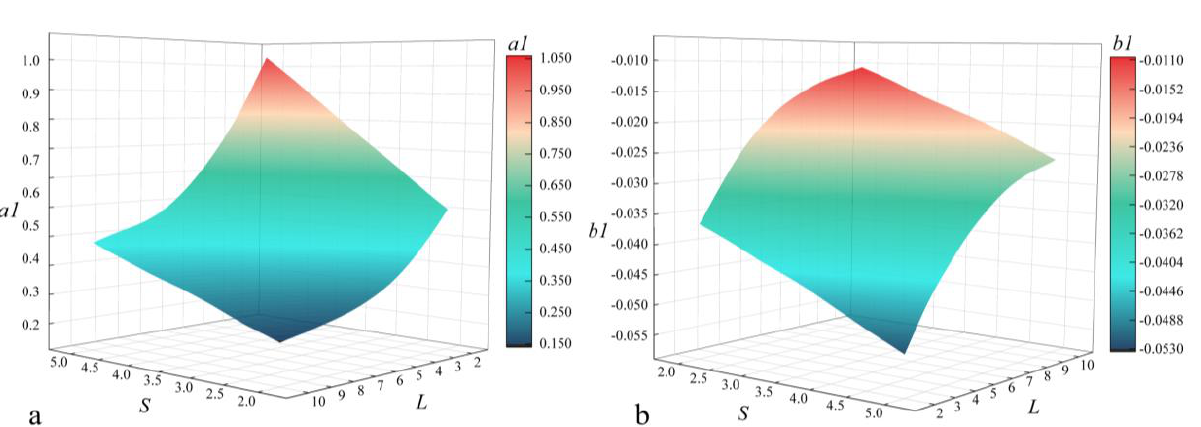
Figure 8. The variations of a1 and b1 with S and L. ( a ): a1 changes with respect to S and L ; ( b ): b1 changes with respect to S and L .